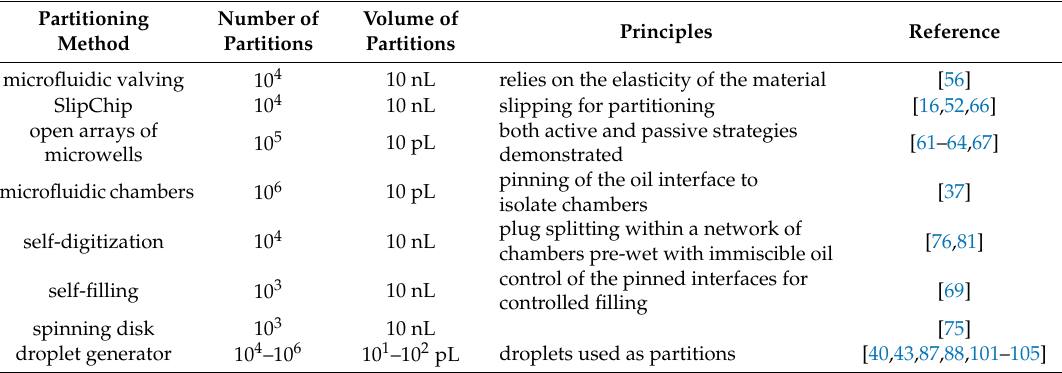
Table 2. Summary of partitioning platforms for